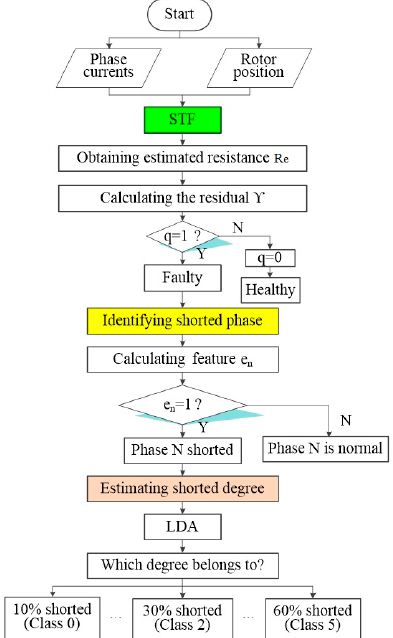
Figure 5. Flow diagram for the inter-turn shorted-circuit fault (ISCF) diagnosis and